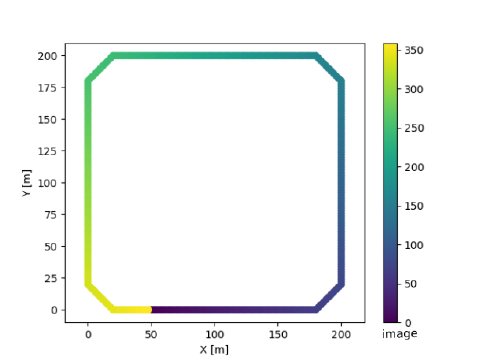
Figure 7. Results of visual localization by using dynamic GCPs in a random tie point cloud.